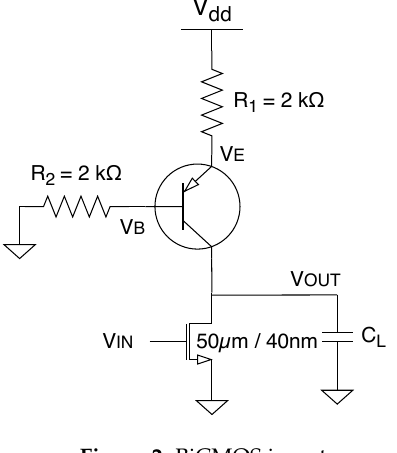
Figure 2. BiCMOS